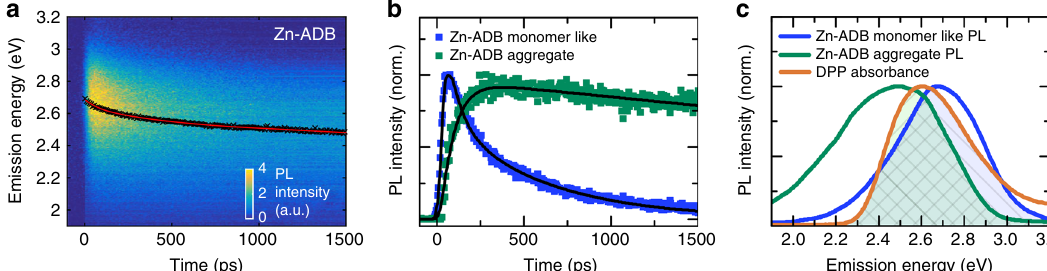
Fig. 2 Excited states in Zn-ADB (1). a Streak image of Zn-ADB (1) excited at 3.26 eV. The peak positions of the PL spectrum at each time ( x ) are indicated by black dots. The red line shows a spline fi t. b Decay and rise of the PL Mon and PL Exc states, respectively. The PL transients are fi tted by biexponential deconvolution fi ts (black solid lines). c PL spectra of the donor PL Mon and PL Exc states together with the acceptor DPP absorption. Both, the transients and the emission spectra in b and c have been determined by using a multivariate curve resolution fi t 29 with a constrained alternating least squares